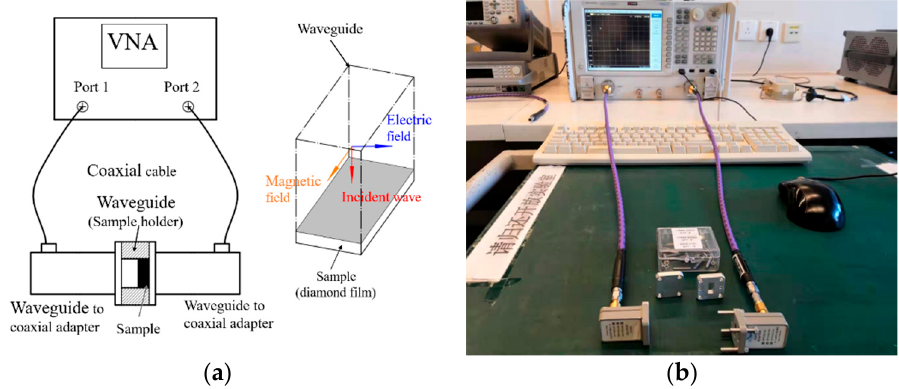
Figure 2. ( a ) Transmission/reflection (T/R) measurement scheme; ( b ) practical measurement system.